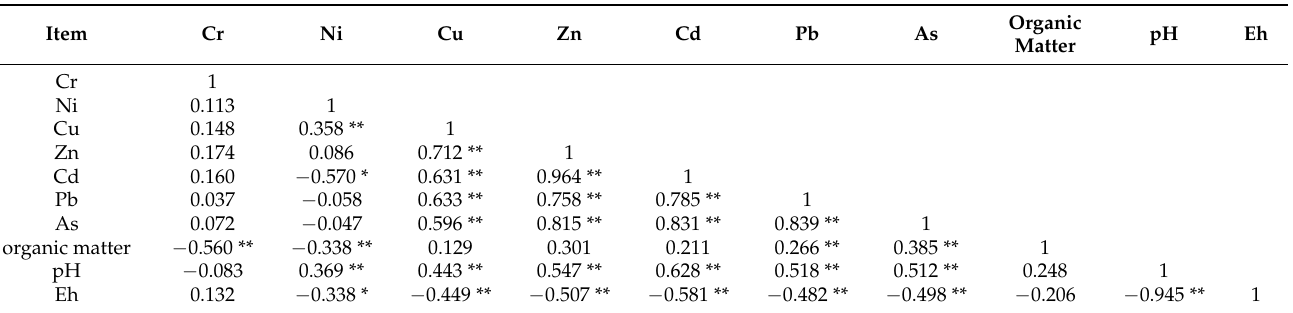
Table 5. Correlation coefficients among heavy metals, pH, Eh, and organic matter.